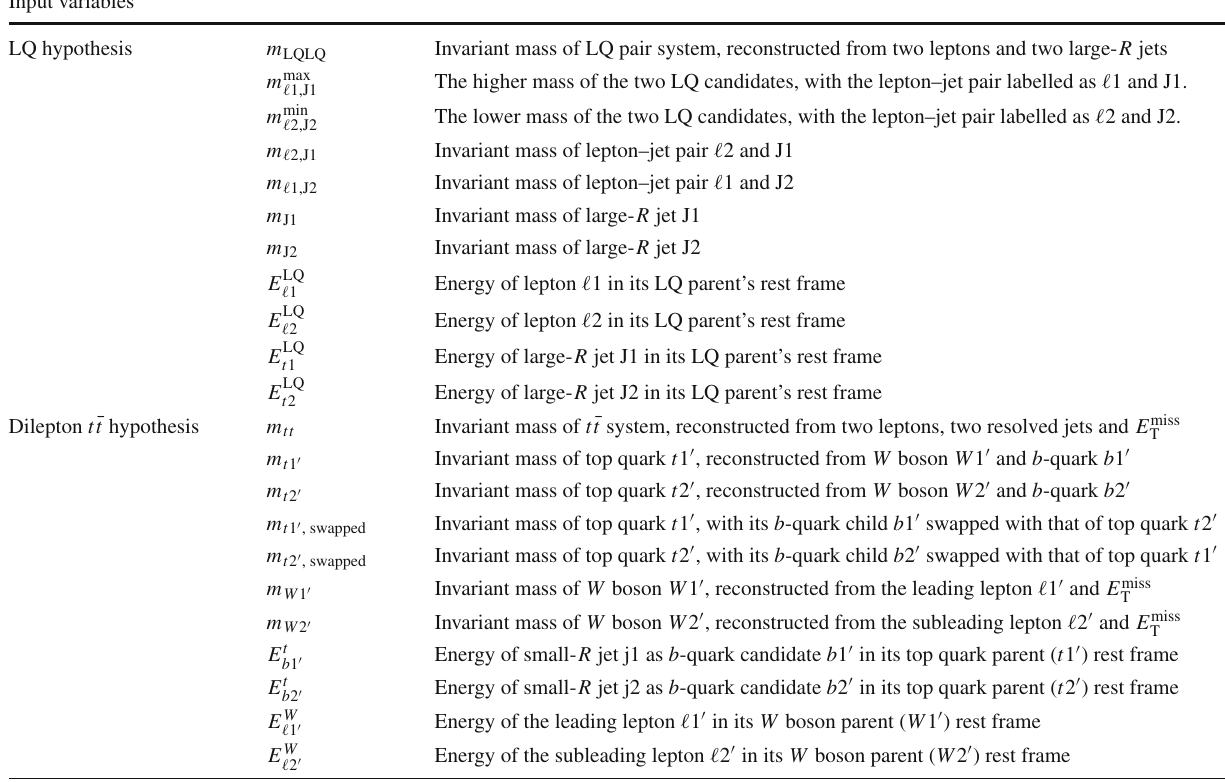
Table 3 The discriminating variables used in the signal–background discrimination training can be classified into five different groups. The first three groups include kinematic variables that are physics-based rather than detector-based, conditioned on different physics process hypotheses: LQ, dileptonic t ¯ t and leptonic Z decay hypothesis. These physics-based kinematic variables include the invariant masses and the momenta of intermediate and final-state particles in their parent’s rest frame. In the dileptonic t ¯ t decay hypothesis, the combinatoric ambigu- ity in the small- R -jet–lepton pairing is resolved using the ‘min (cid:10) M top